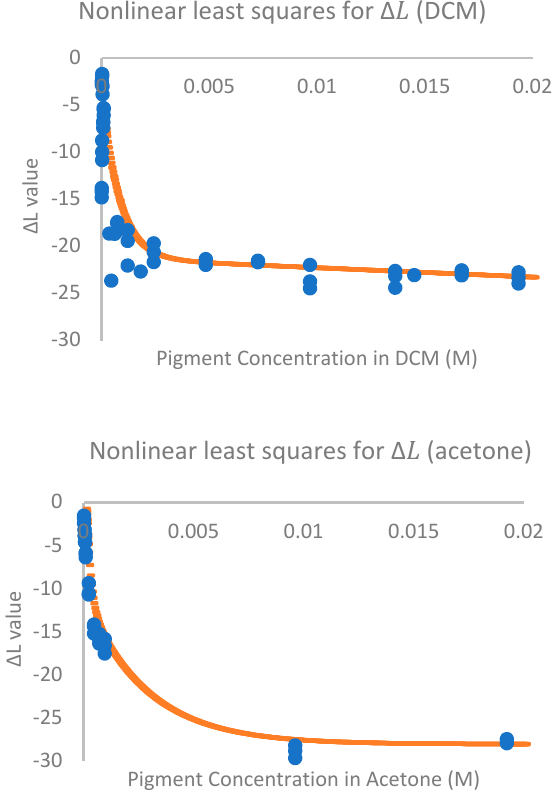
Figure 1. Molarity vs. Δ L Color Value for the crystal ‘Dramada’ from Scytalidium cuboideum. The upper image corresponds to DCM and the bottom one to acetone.